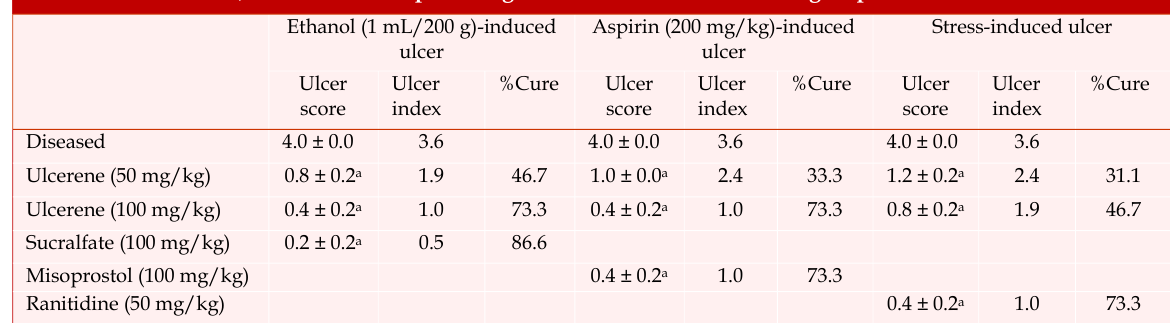
Ulcer score, ulcer index and percentage cure of different treatment groups in ulcerative rats Ethanol (1 mL/200 g)-induced Aspirin (200 mg/kg)-induced ulcer ulcer